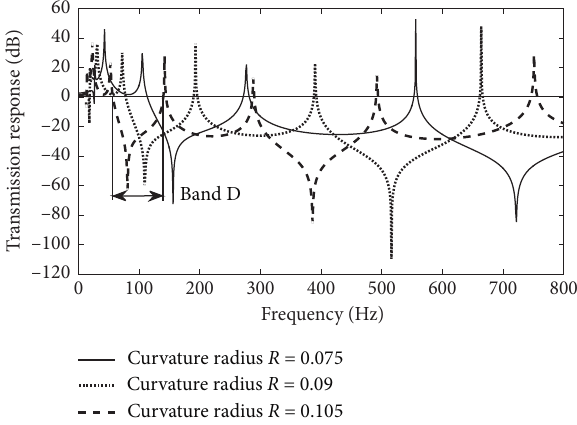
Figure 16: Transmission response for the curved beam with dif- ferent curvature radius.